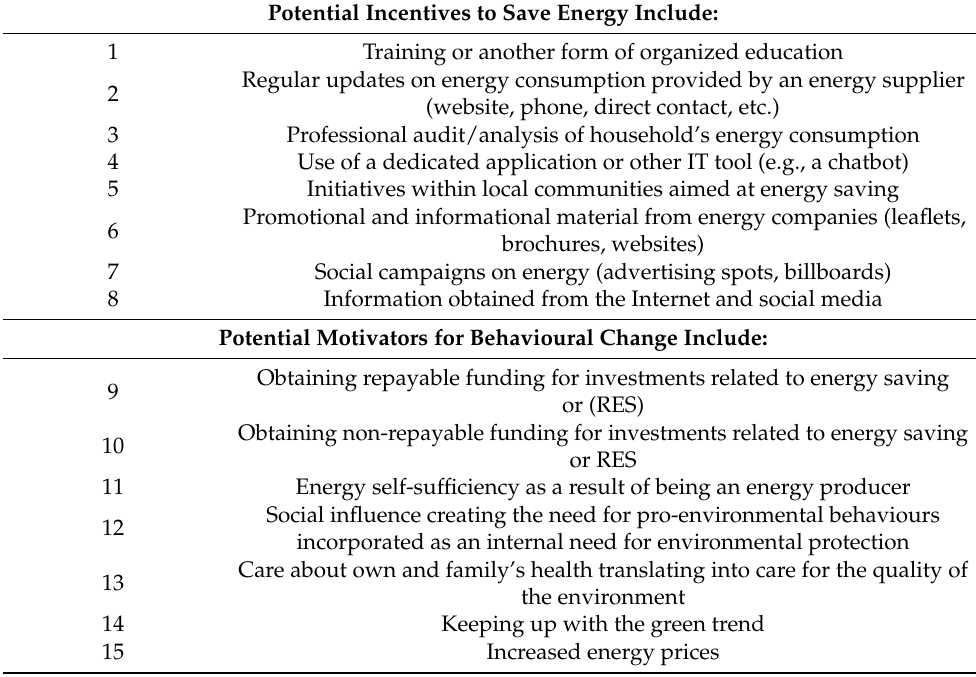
Table 1. External incentives and motivators, included in the survey, which could potentially encour- age respondents to save